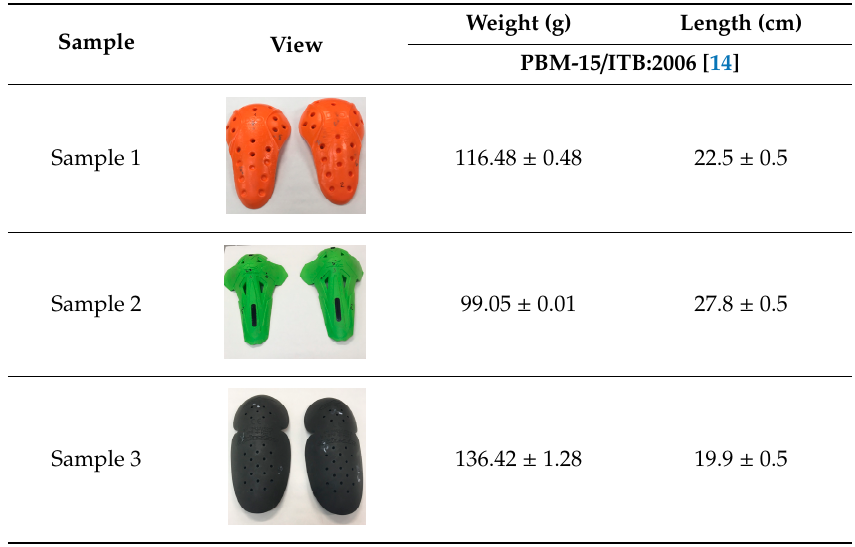
Table 1. Selected protectors used in clothing for motorcyclists.